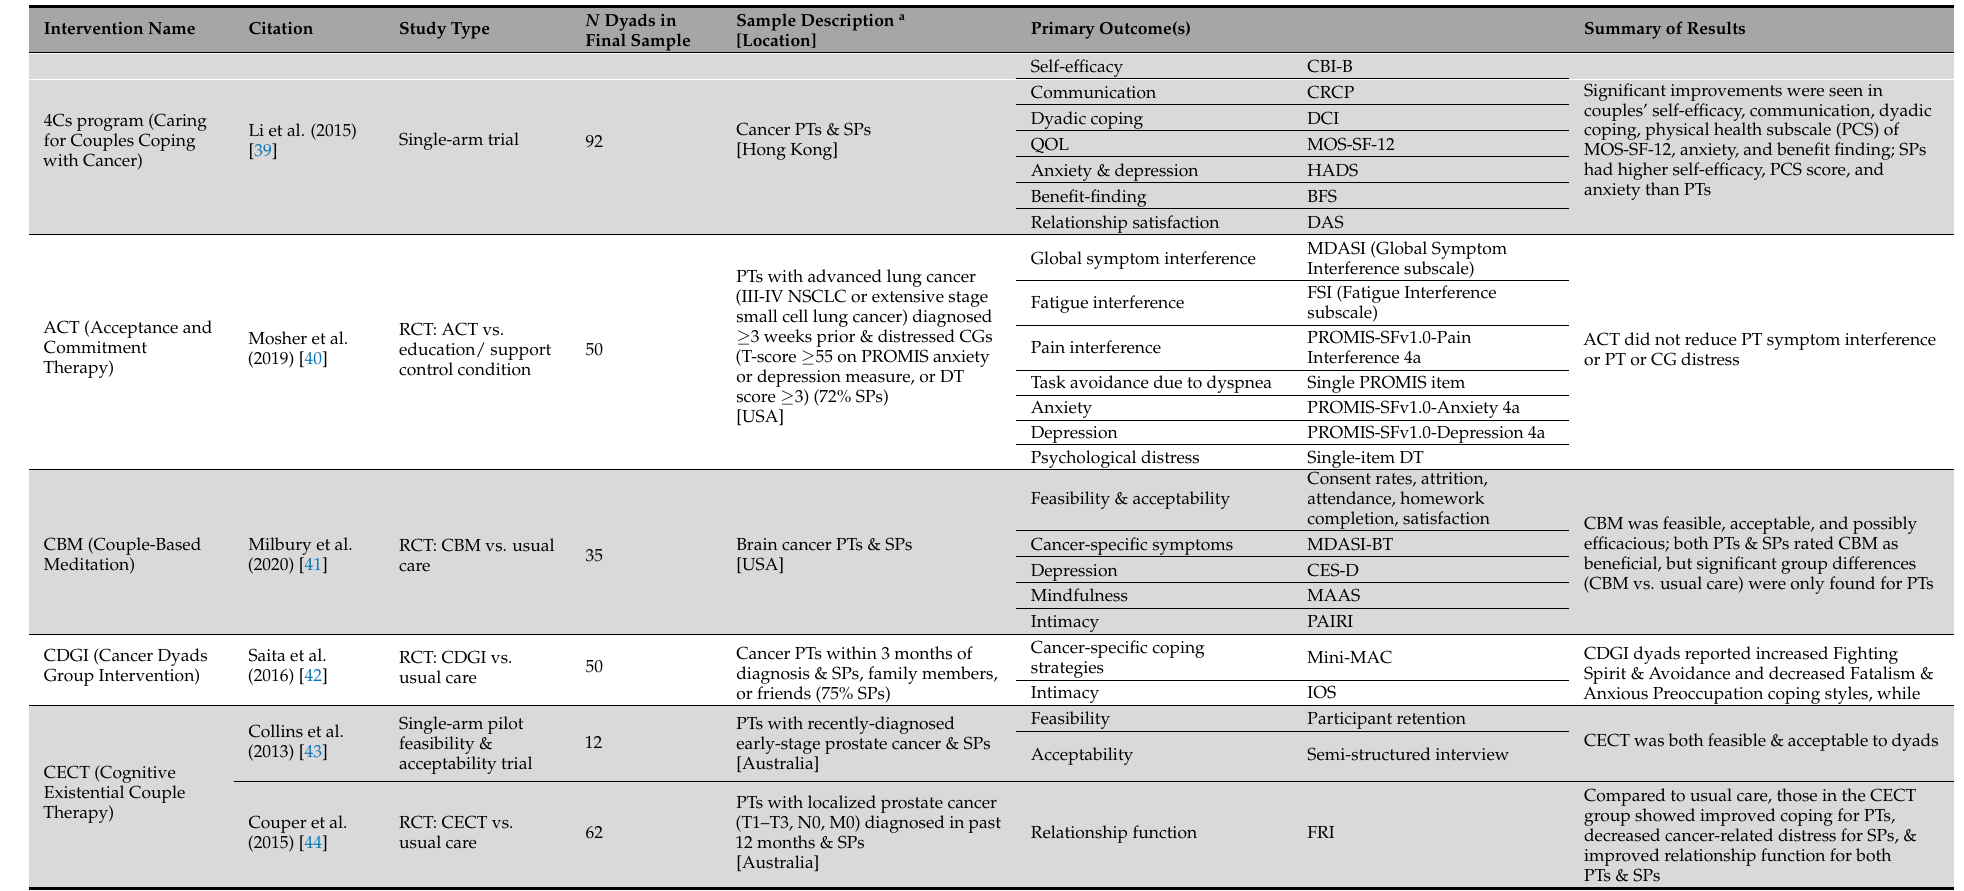
Table 1. Summary of Studies Included in this